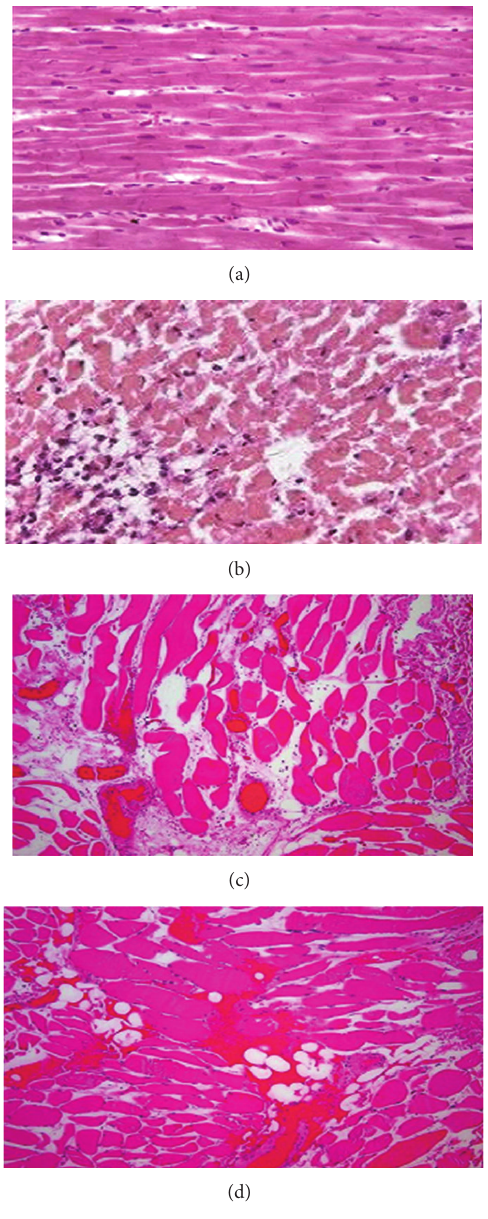
Figure 8: Light micrograph of heart tissue from rats treated with (a) normal control, (b) doxorubicin treated, (c) doxorubicin + test compound 50 mg/kg, and (d) doxorubicin + test compound